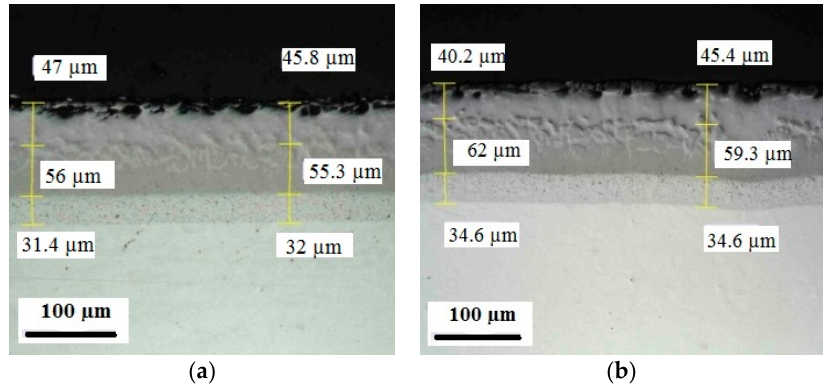
Figure A12. Microscopic images of the cross-section of 316-A-Sn ( a ) before and ( b ) after the low-temperature corrosive attack after 168 h.